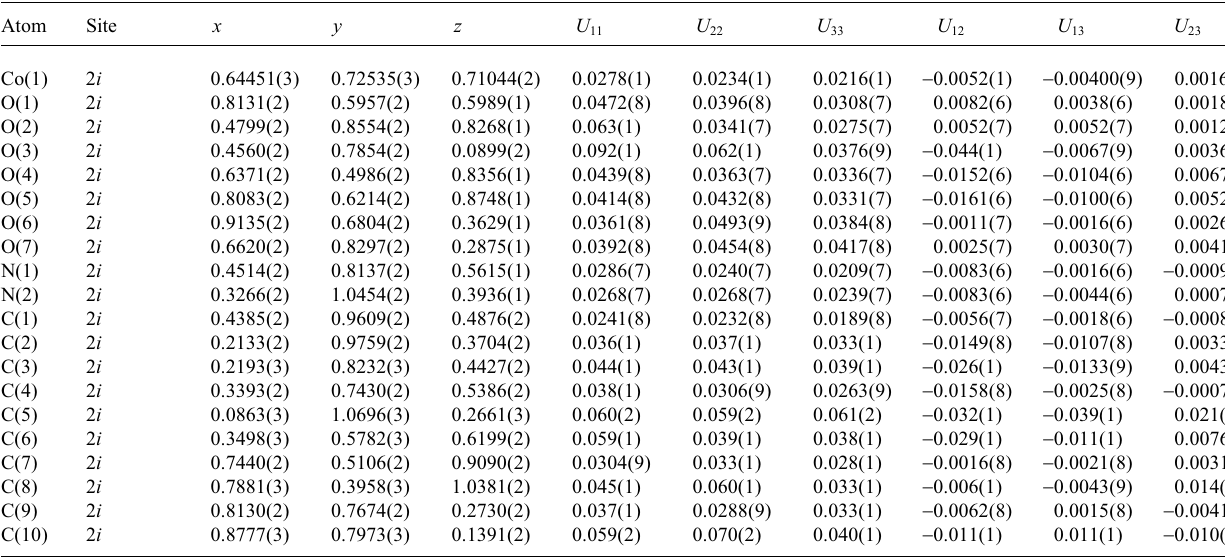
Table 3. Atomic coordinates and displacement parameters (in Å 2 ) .